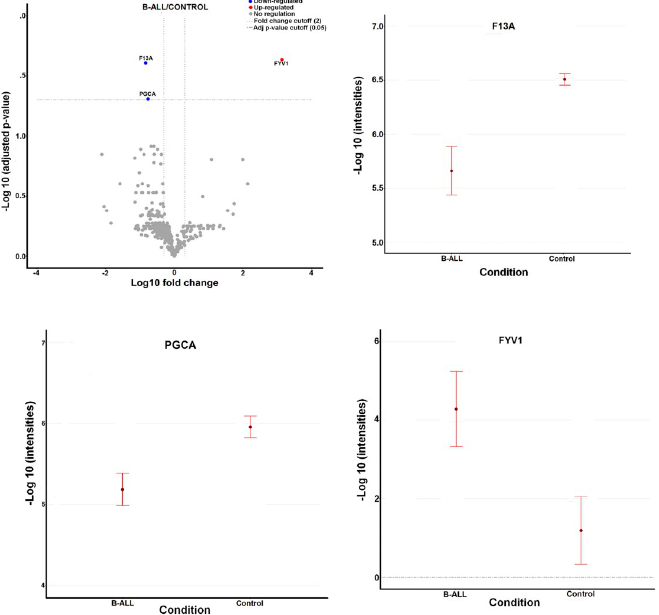
Fig 1. MSStats statistics. A. Volcano plot of the comparison B-ALL vs Control. The dashed line represents the false discovery rate (FDR) cutoff 5% and fold-change cutoff = 2.0. The up-regulated protein is shown in red dots and down- regulated in blue dots. Condition plots for FYV1 (B), PGCA (C) and F13A (D) proteins. Dots indicate the mean of log ratio and error bars have confidence intervals with 0.95 significant level for each condition.